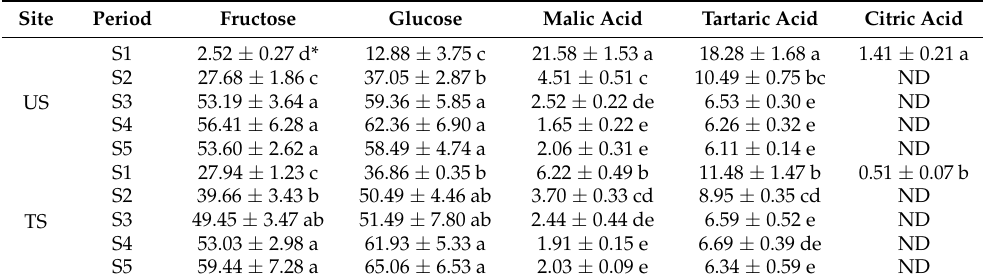
Table 1. The saccharide and organic acid contents (mg · g − 1 FW) in grape berries during the five developmental stages in Urumqi (US) and Turpan